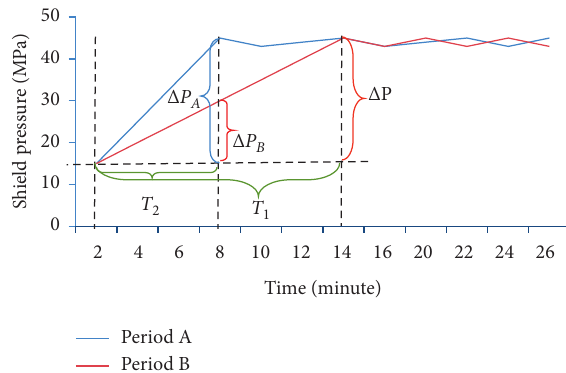
Figure 5: Supporting load variation after the initial setting in two periods.